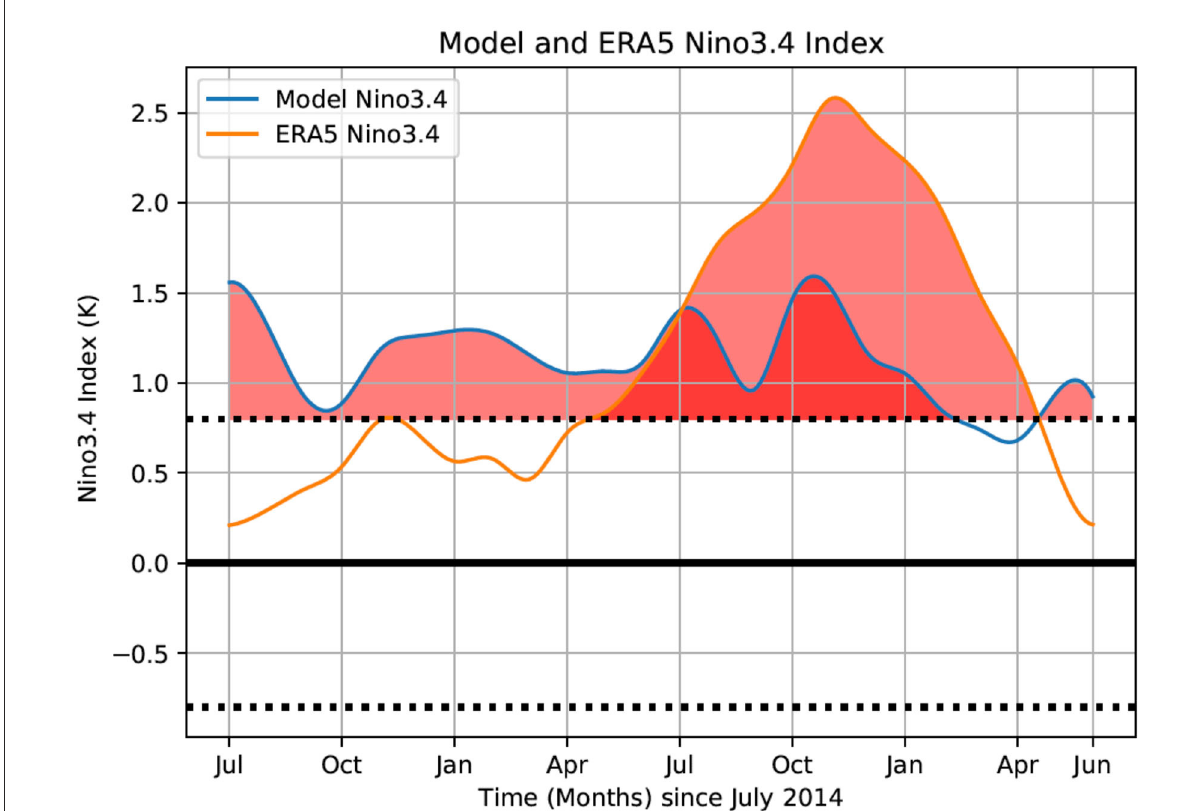
FIGURE13 Model predictions of the El Niño 3.4 index for a 24-month prediction starting in July 2014 and ending in June 2016. We compare the model results with the El Niño 3.4 index, defined as the monthly average SST computed over the region 5 ◦ N-5 ◦ S and 120 ◦ W-170 ◦ W, calculated from the monthly mean ERA5 SST data. The dotted lines define warm ( > 0.8 ◦ C) and cold ( < − 0.8 ◦ C) periods. Model predictions and ERA5 estimates of the El Niño 3.4 index > 0.8 ◦ C have been shaded red, and values < − 0.8 ◦ C have been shaded blue, for